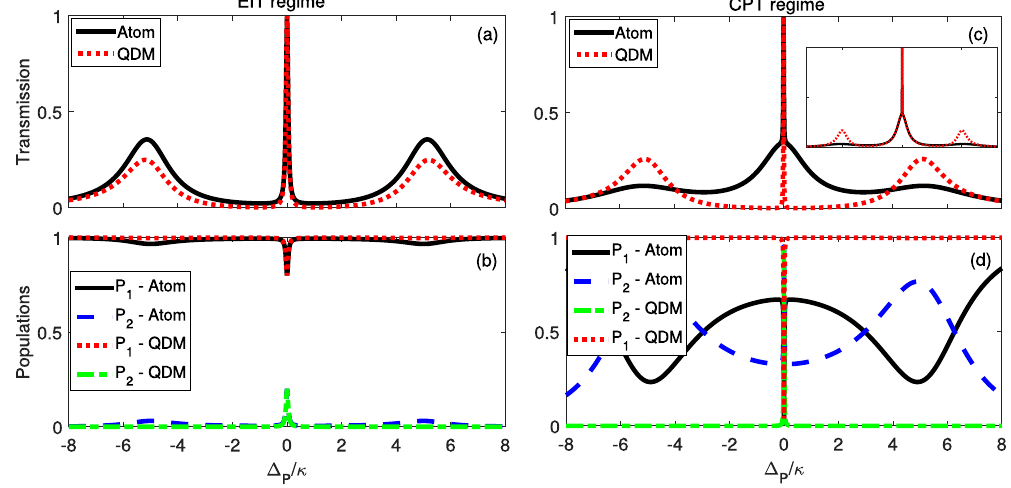
Figure 4. Transmission spectrum and populations. Painels (a,c) (top) show the normalized cavity transmission and panels (b,d) (bottom) show the atomic and QDM populations, both as a function of the detuning Δ P / κ . The parameters used here are κ = Γ , g = 5 κ , ε κ = . 0 01 , and κ Θ = . 1 0 for the EIT (panels ( a,b ), on the left) and κ Θ = . 0 1 for the CPT regimes (panels ( c,d ), on the right), and Γ = Γ = . Γ 0 5 for the atomic system and 31 32 Γ = Γ and Γ = 0 for the QDM one. For small values of the control field Rabi frequency or Tunnelling rate 31 32 ( Θ → 0 ), the non null Γ leads the population of the system to the ground state |2 〉 , which is not coupled to the 32 cavity mode, thus increasing the transmission (empty cavity situation). This is equivalent to an effective decay from level |1 〉 to |2 〉 – see inset of panel (c), where we have included the effective decay in the QDM-cavity